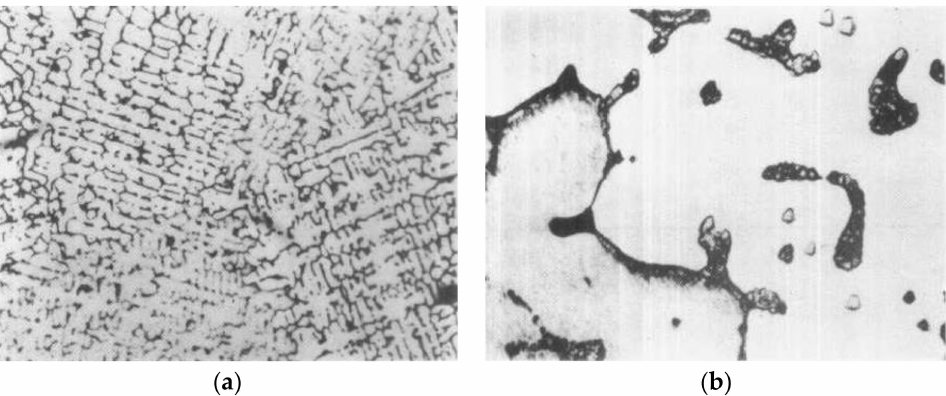
Figure 2. Metallographic structure of the pure copper: ( a ) amplification factor, 60; ( b ) amplification factor, 150.